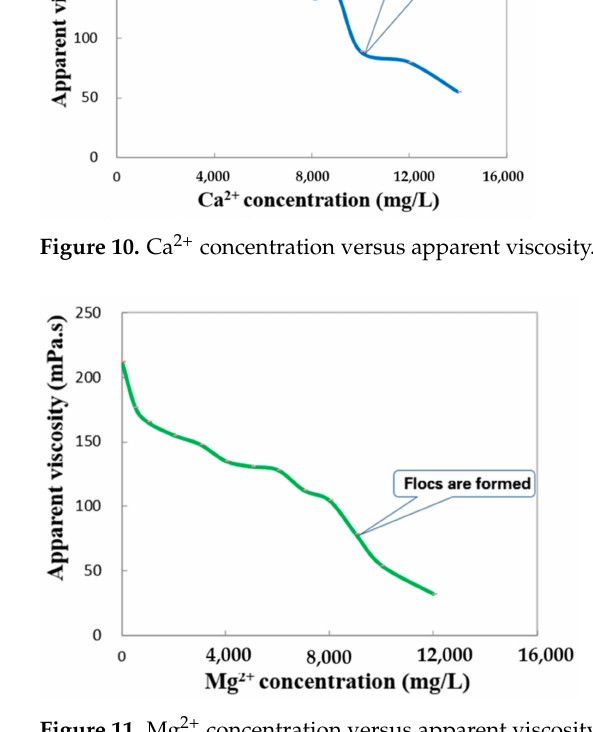
Figure 11. Mg 2+ concentration versus apparent